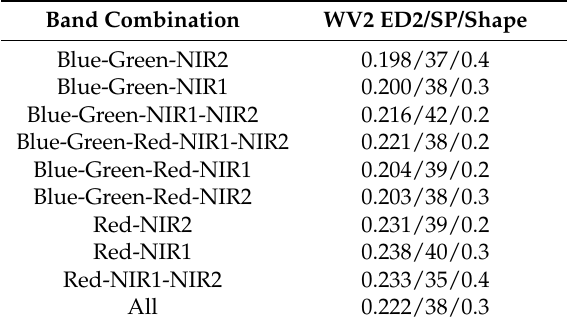
Table 3. The modified ED2 and its associated scale (SP) and shape parameters (compactness was fixed to 0.5) for the tested WorldView2 (WV2) equal-weighted band combinations. In grey, the best results